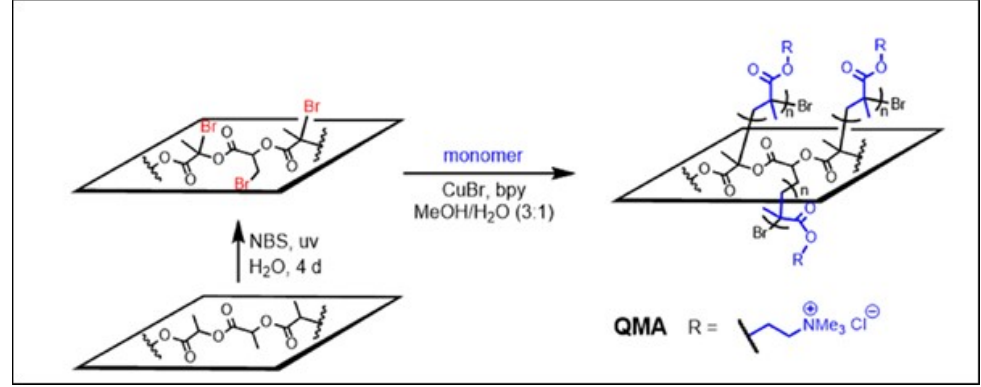
Figure 18. Surface-initiated ATRP of methacrylate monomers (from Kalelkar et al. [93], copyright Elsevier, reproduced with permission).